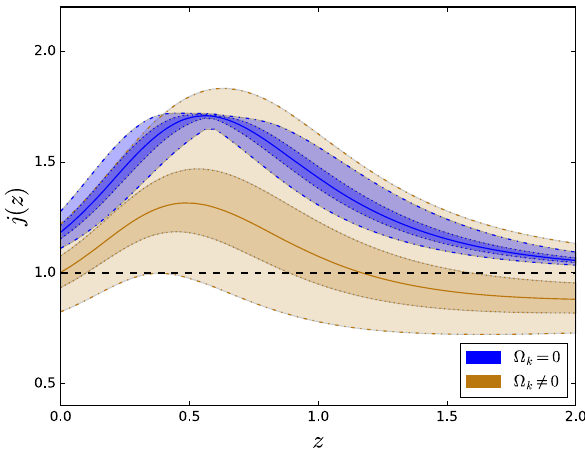
Fig. 4 Reconstruction of the jerk parameter using the constraints from the joint analysis for both cases, flat (blue color) and non-flat (brown color) models. The horizontal dashed line corresponds to the Λ CDM model. The uncertainty bands refers to 68% (inner band) and 99 . 7% (outermost band)